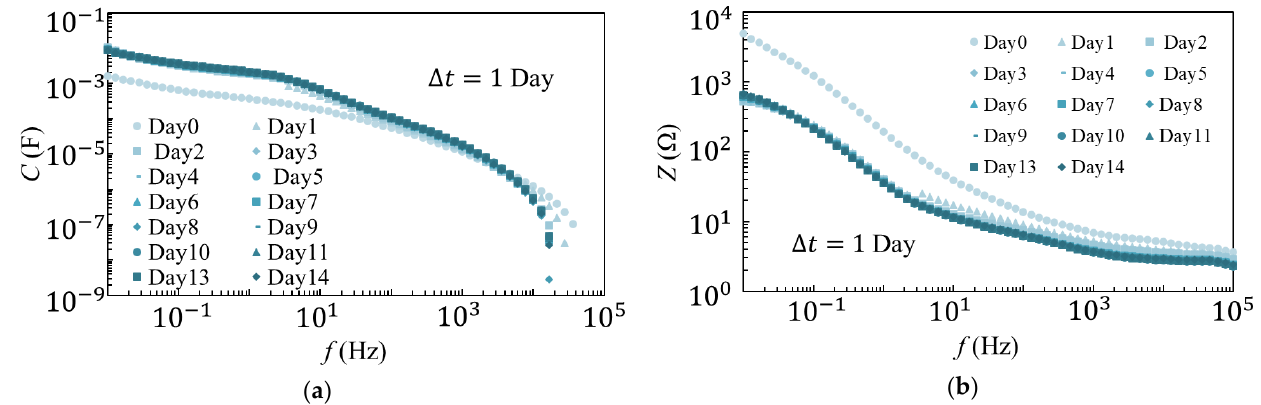
Figure 2. Measurement results of ( a ) C and ( b ) Z in the 25 °C degradation tests. Because voltage dependence of the EDLC was not observed at 1 kHz, the time de-